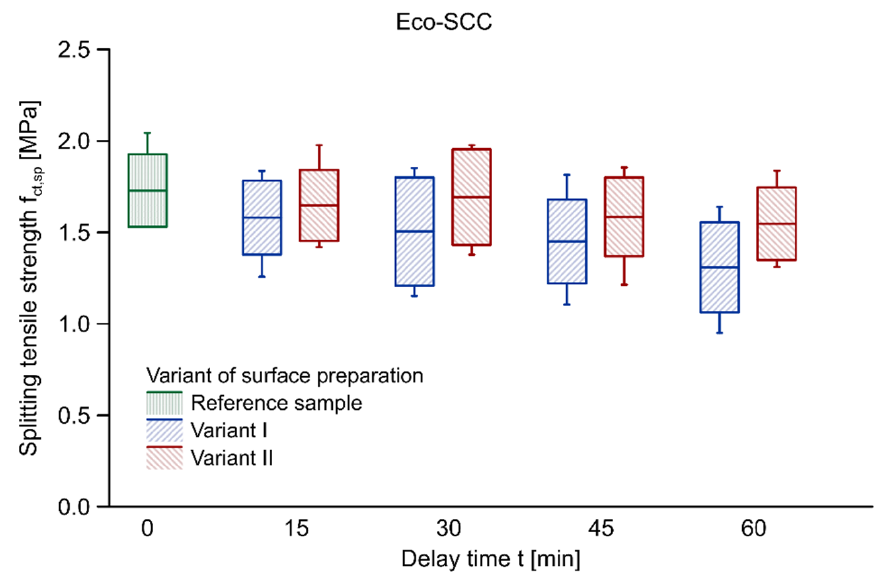
Figure 3. Splitting tensile strength vs. delay time between layers of Eco-SCC concrete.